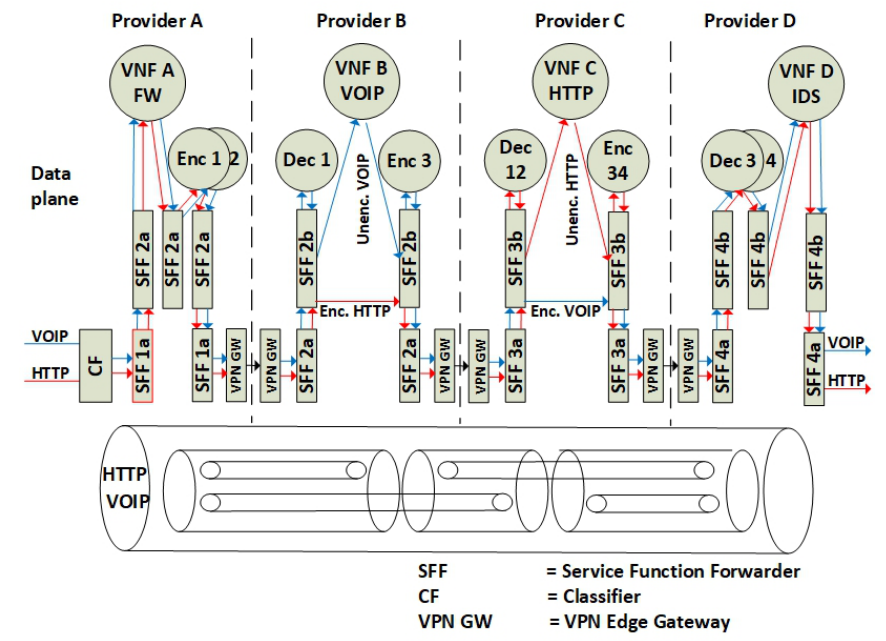
Figure 14. Services on the